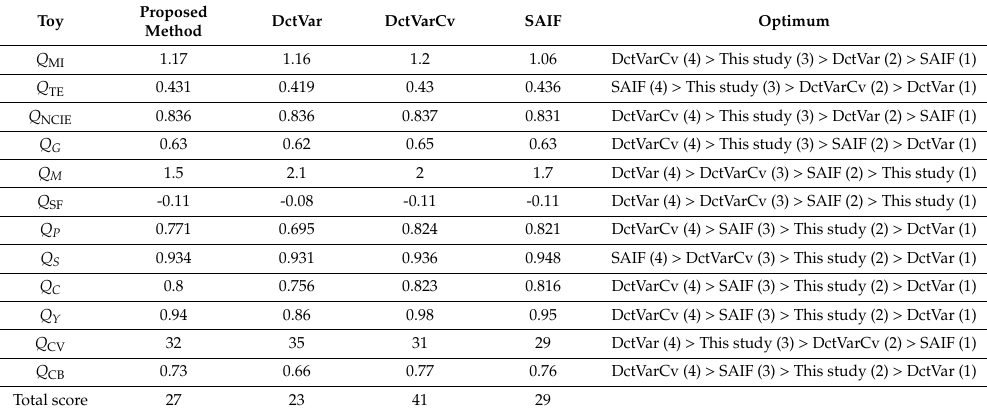
Table 6. List of toy fusion results and fusion quality